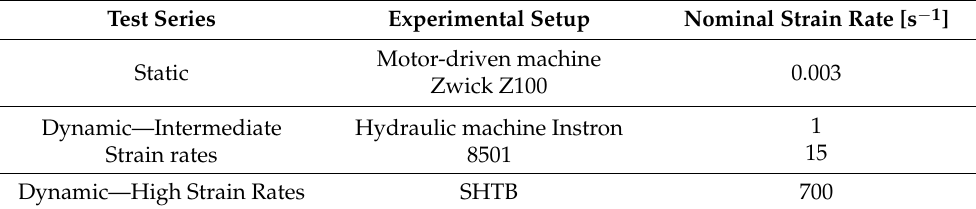
Table 1. Experimental setups adopted to obtain the desired strain rates.